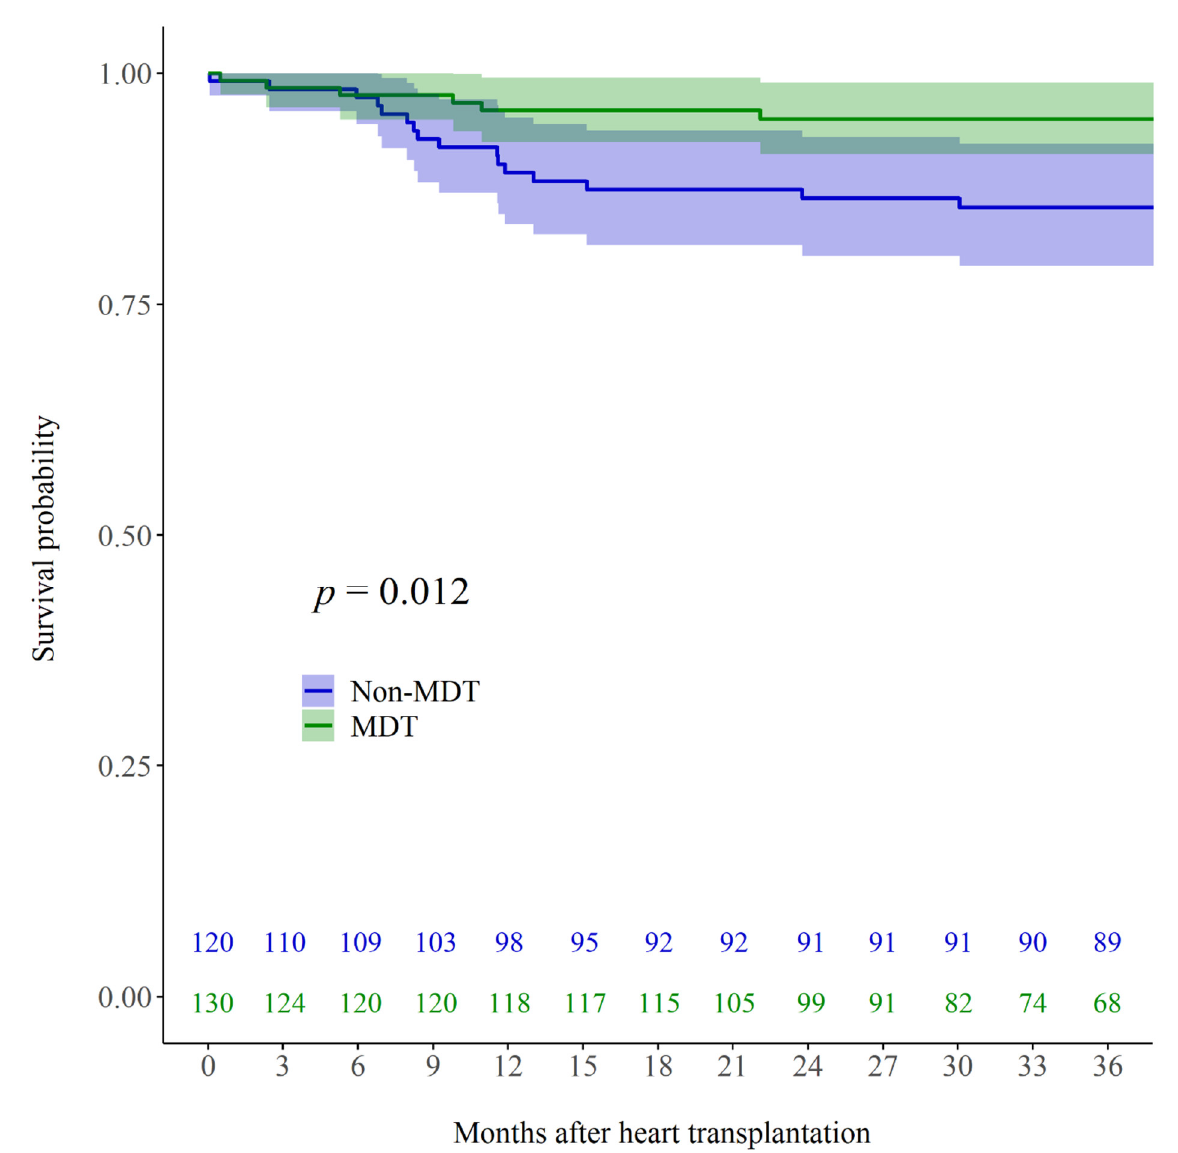
Figure A2. Kaplan–Meier post-heart transplantation survival curves for cardiac-related survival in 408 patients who underwent heart transplantation with the multidisciplinary team approach (MDT group; 409 green line) and without the multidisciplinary team approach (non-MDT group; blue line). 410. MDT, multidisciplinary team.